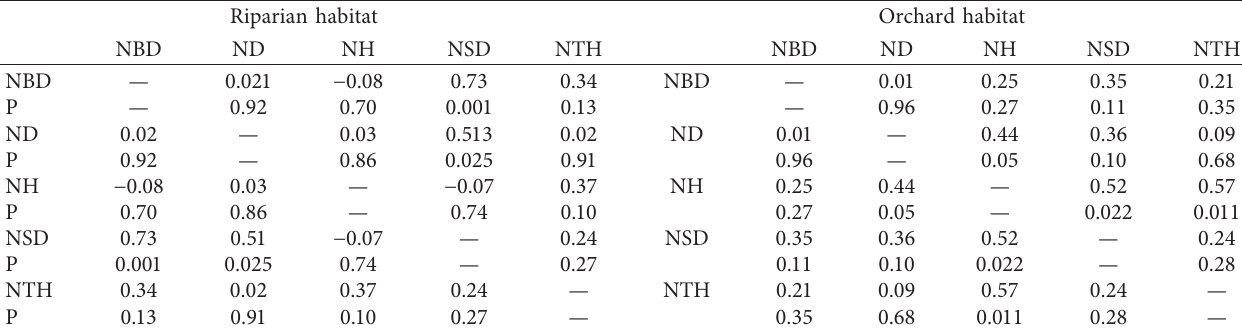
Table 2: Pearson’s correlation coefficients among nest placement characteristics and dimensions of the turtle dove in orchard and riparian habitats. Riparian habitat NBD